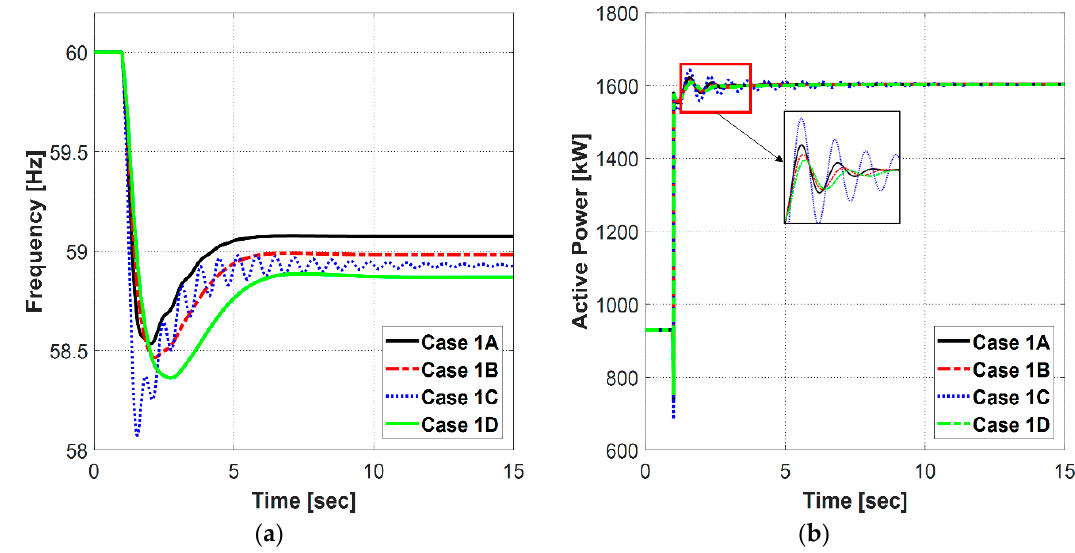
Figure 8. Results after the photovoltaic (PV) generation decreased from 680 kW to zero for Cases 1A–1D: ( a ) frequency response; ( b ) power output from the diesel generators.